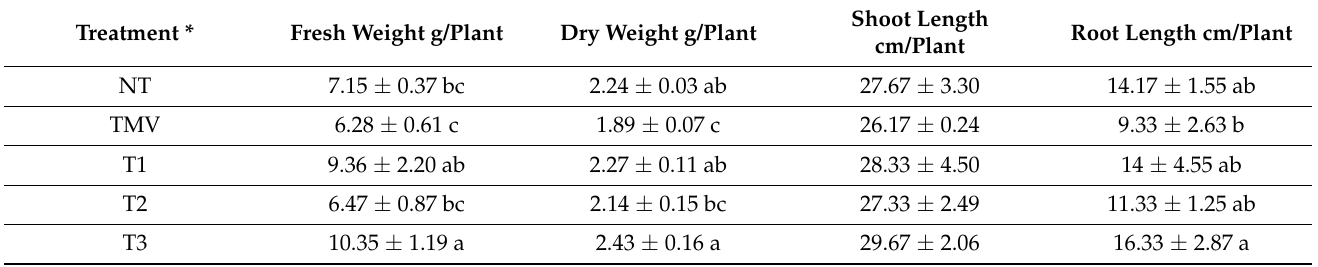
Table 2. Effect of foliar application of B. subtilis strain HA1-CF on growth parameters of tomato plants at 22 days post-TMV